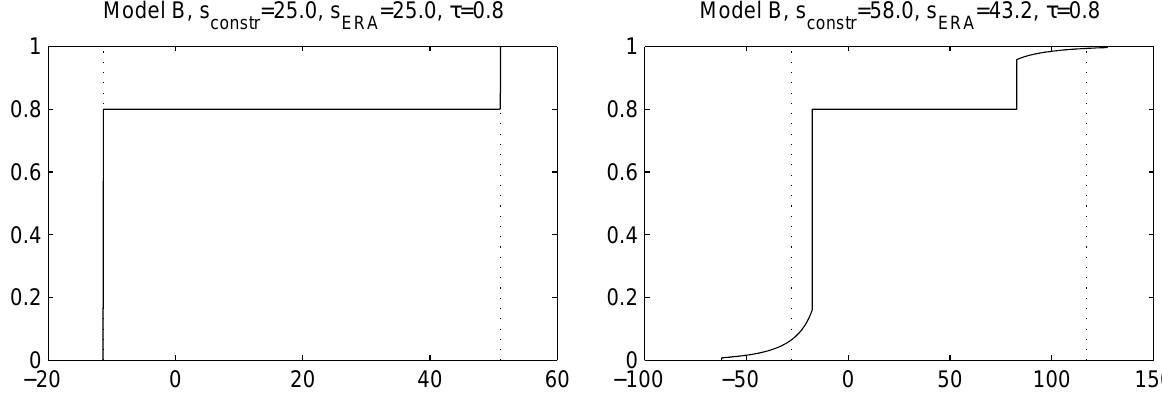
Figure 3. Distribution function of S computed using ERA for Model B, τ “ 0 . 8 . In the left panel, a standard deviation constraint s “ 25 is applied and attained by ERA. In the constr right panel, a constraint s “ 58 is attempted, but cannot be attained, resulting in a lower constr actual standard deviation s “ 43 . 2 ; moreover, the distribution is not diatomic. The dotted ERA lines are the optimal locations of the atoms from Theorem